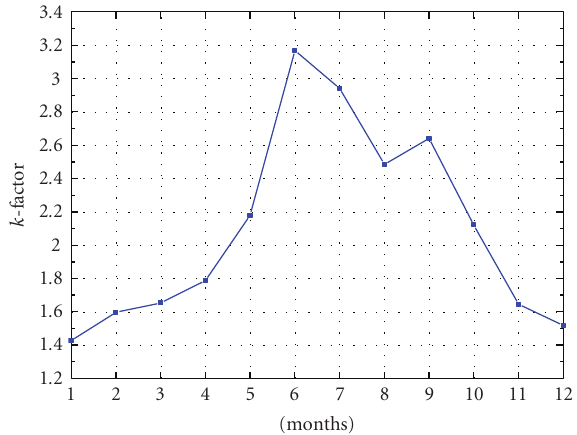
Figure 1: Monthly distribution of median k -factor.